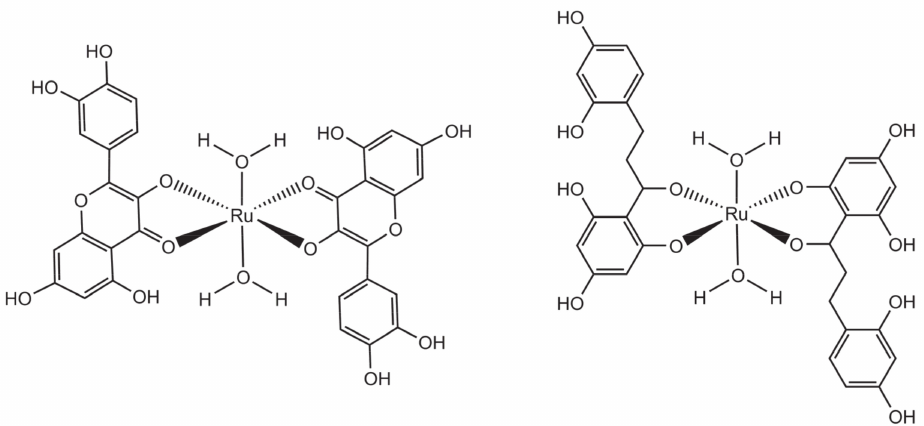
Figure 5. Structural representation of the complexes [Ru(quercetin) 2 (H 2 O) 2 ] (left) and [Ru- (phloretin) 2 (H 2 O) 2 ]